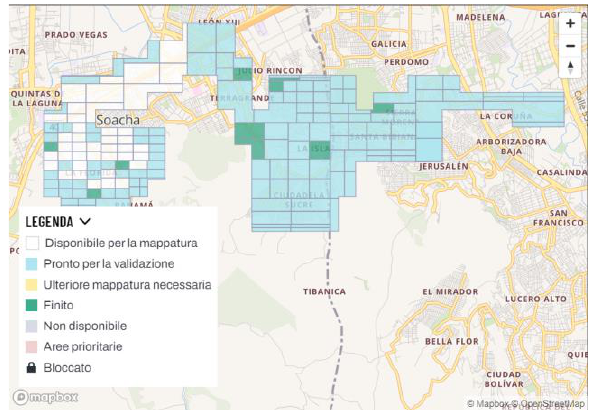
Figure 6 . Screenshot of the online task on TeachOSM Tasking Manager during the Mapathon event.